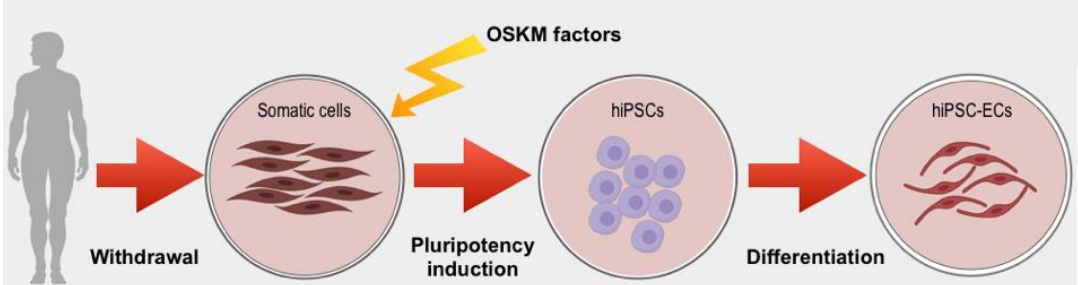
Figure 2. Schematic representation of human Induced Pluripotent Stem